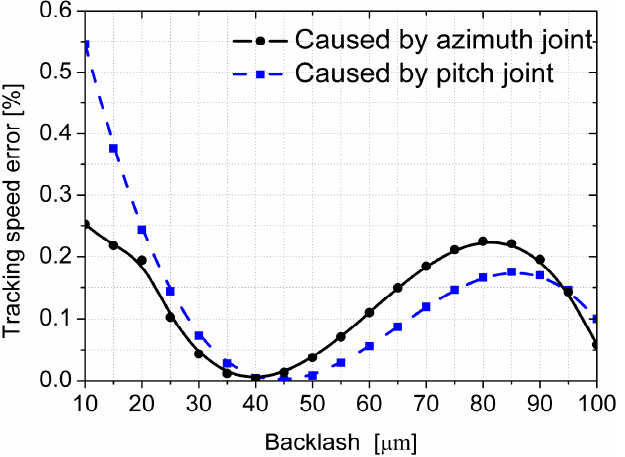
Figure 10. Tracking speed error of the antenna reflector with different backlashes—the solid line of dot-point represents the backlash in the azimuth joint; the dashed line of square-point represents the backlash in the pitch joint.